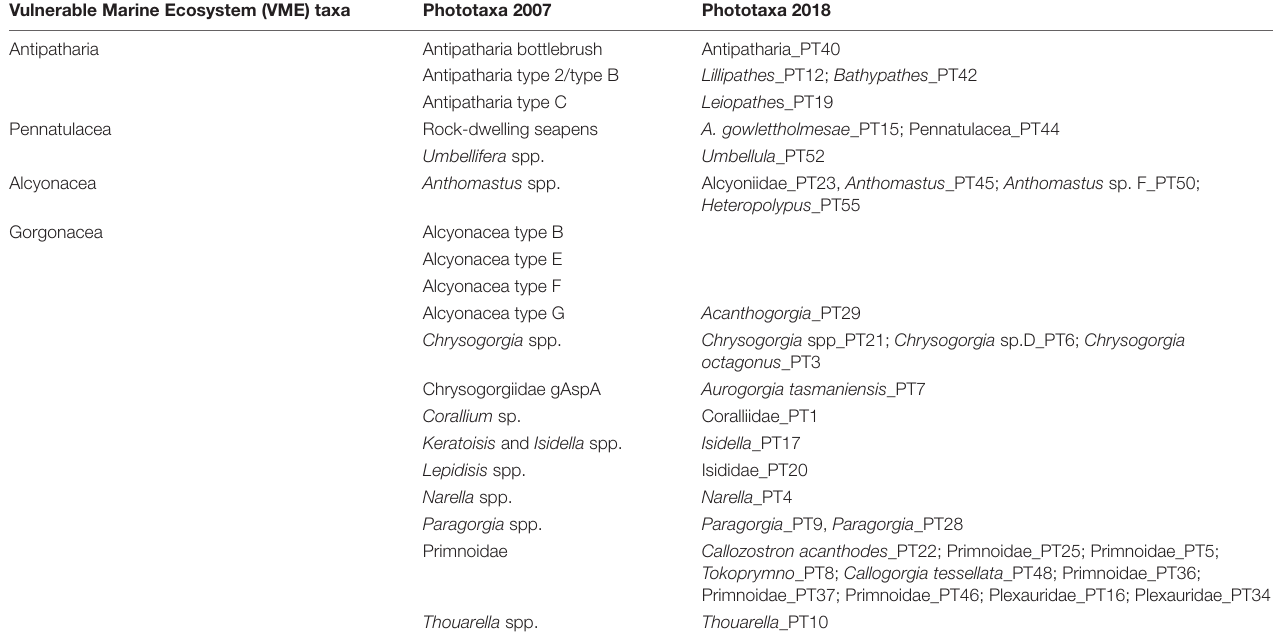
TABLE 2 | VME indicator groups of phototaxa and a comparison between black coral and octocoral phototaxa (PT) previously established (Phototaxa 2007) and those established herein (Phototaxa 2018). Vulnerable Marine Ecosystem (VME)